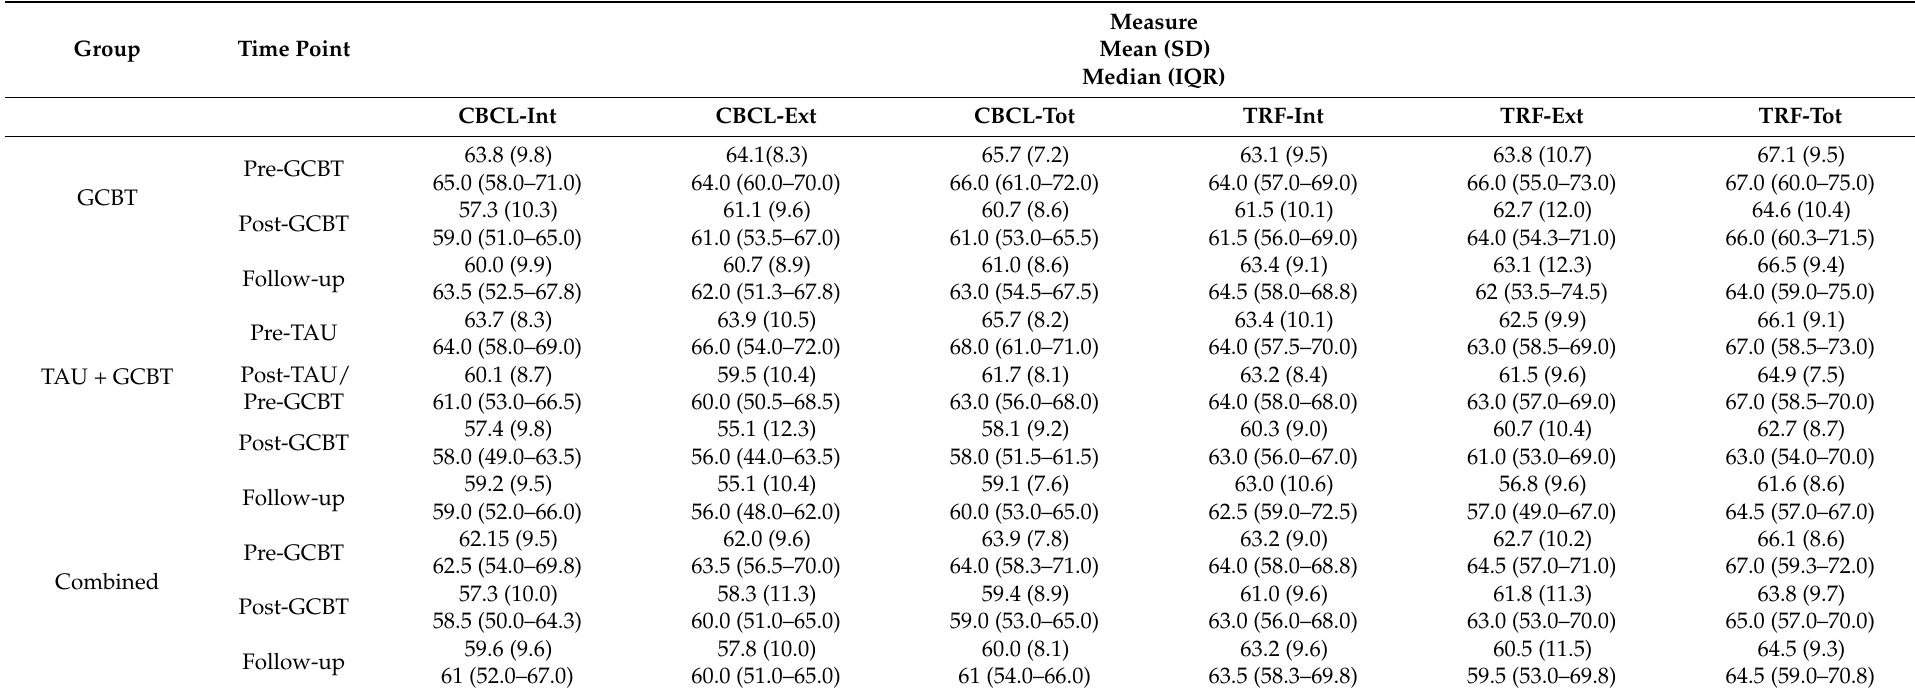
Table 4. Descriptive statistics of the outcome measures at different time